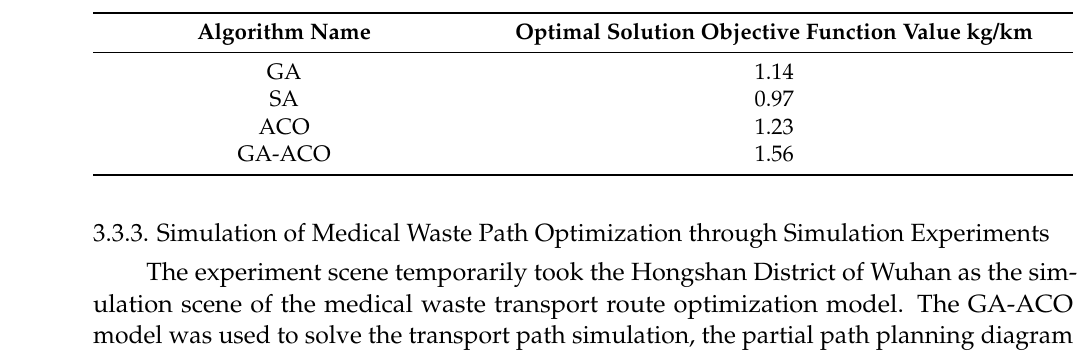
Table 3. Comparison of objective function values of optimal solutions of various algorithms.